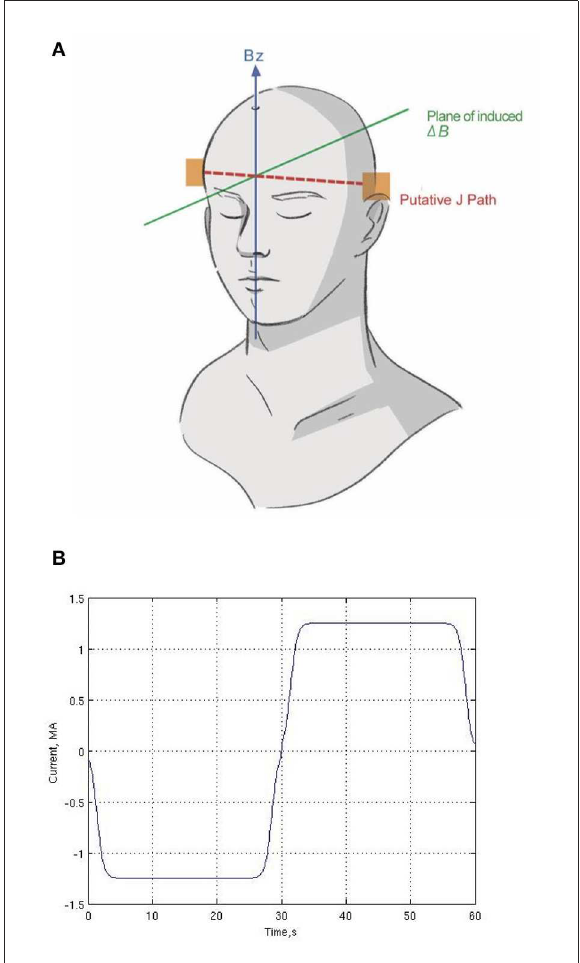
FIGURE1 Human subject experiment setup. (A) Location of two electrodes (T3 and T4) and putative current (J) path and plane of induced magnetic field ( 1 B ). (B) One cycle of the current waveform (repeated six times during the scan). We used a Fermi waveform ( ± 1.25mA; 60-s period) for 6-min stimulation to maximize the RMS current while controlling for abrupt current